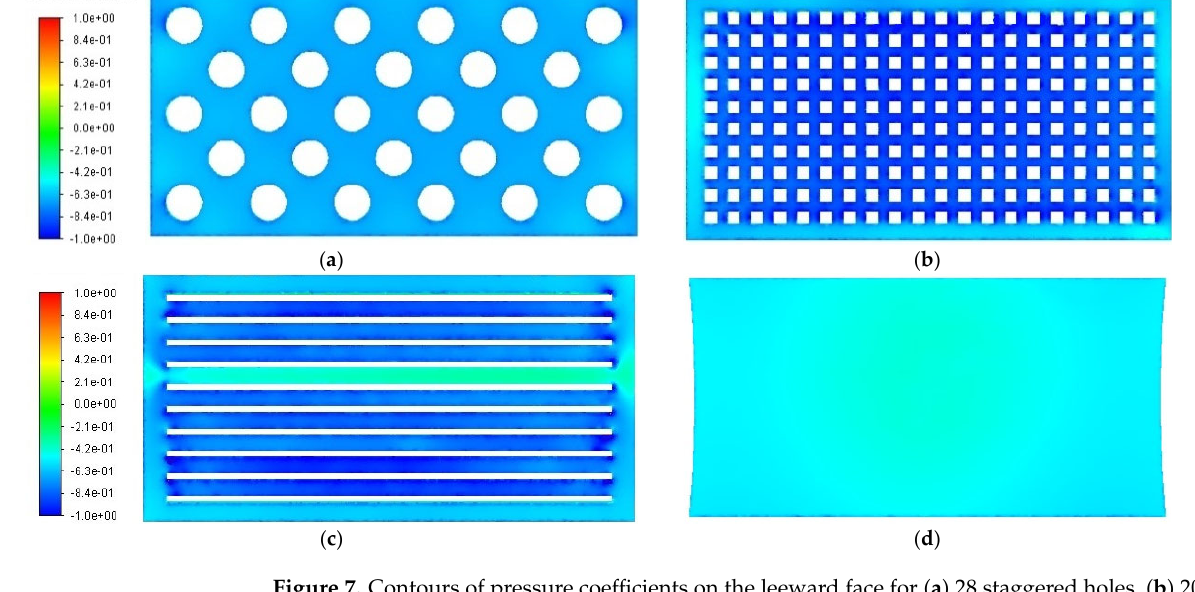
Figure 7. Contours of pressure coefficients on the leeward face for ( a ) 28 staggered holes, ( b ) 200 uniform square holes, ( c ) 10 rectangular slots, and ( d ) curved. Table 1. Drag coefficient comparison between the standard and porous